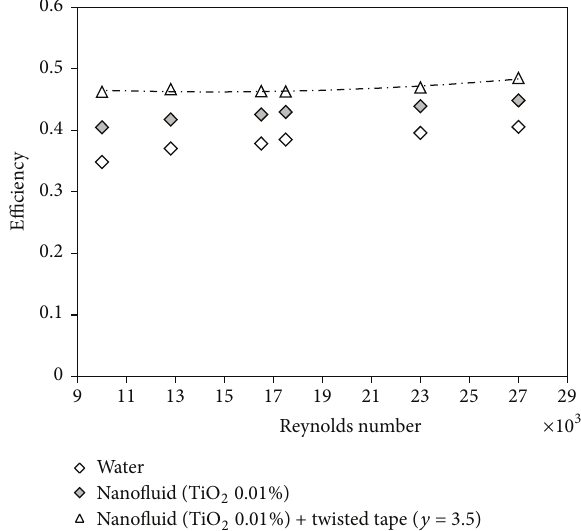
Figure 12: The effect of volume concentration and twisted-tape TiO 2 -water on the efficiency at different Reynolds